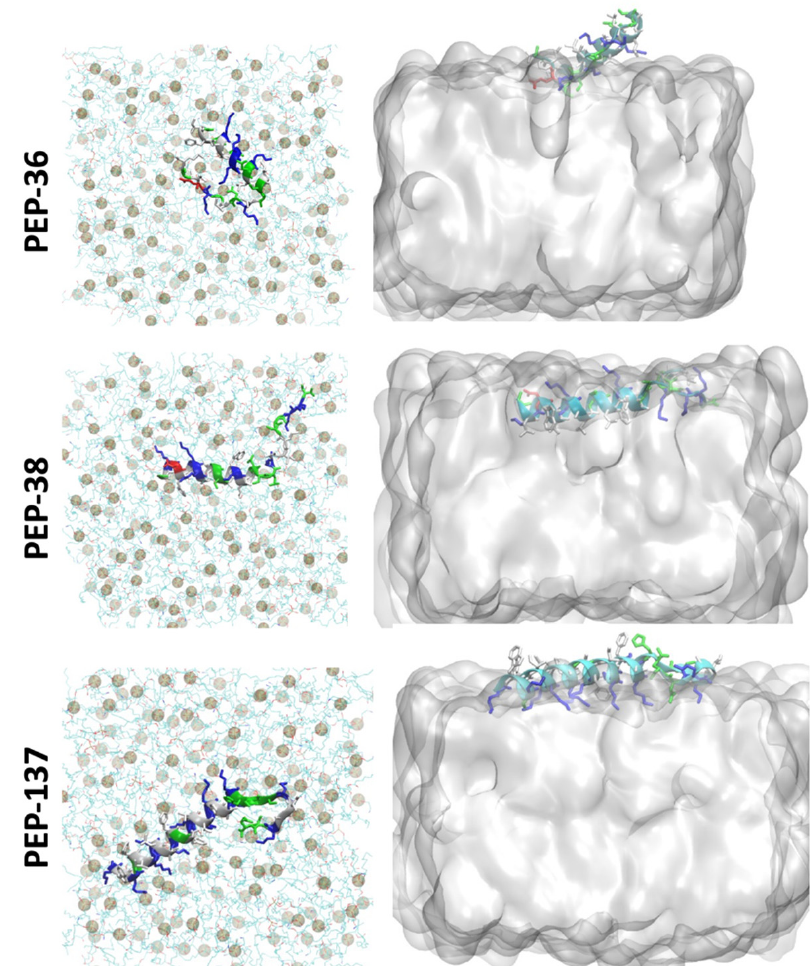
Figure 5. Top view of the peptide-membrane system (left) at 225 ns of MD simulation showing the unravelling of the helical structure. Phosphate atoms of the membrane are shown in gray color. Side view (right) showing the penetration of peptide at 225 ns.